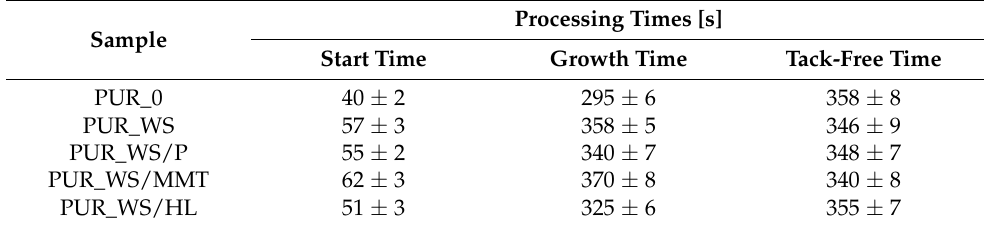
Table 1. Processing times of PUR mixtures containing walnut shell fillers.